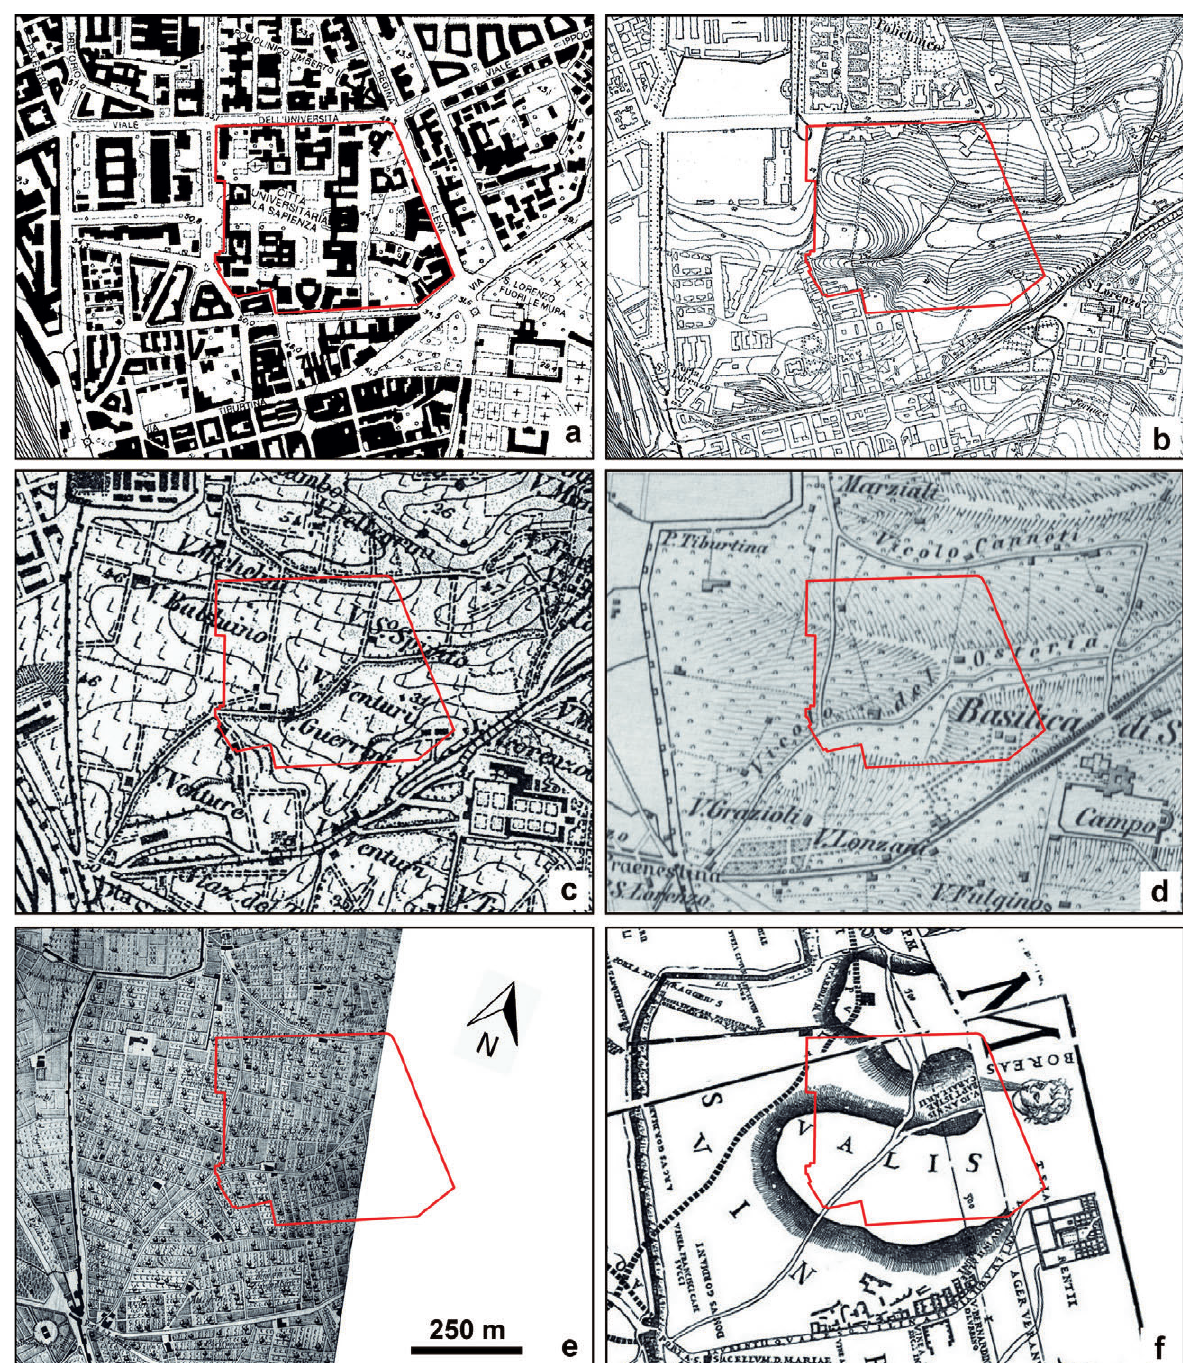
Fig. 7. landscape evolution of the Campus Sapienza area (red polygon) during the last five centuries. a) present day; b) before the construction of the campus (IGM 1924); c) before the modern urbanization (IGM 1873); d) at the time of Pope Pius IX (Moltke 1852); e) at the time of Pope Benedictus XIV (Nolli 1748); f) at the time of Pope Julius III (Bufalini